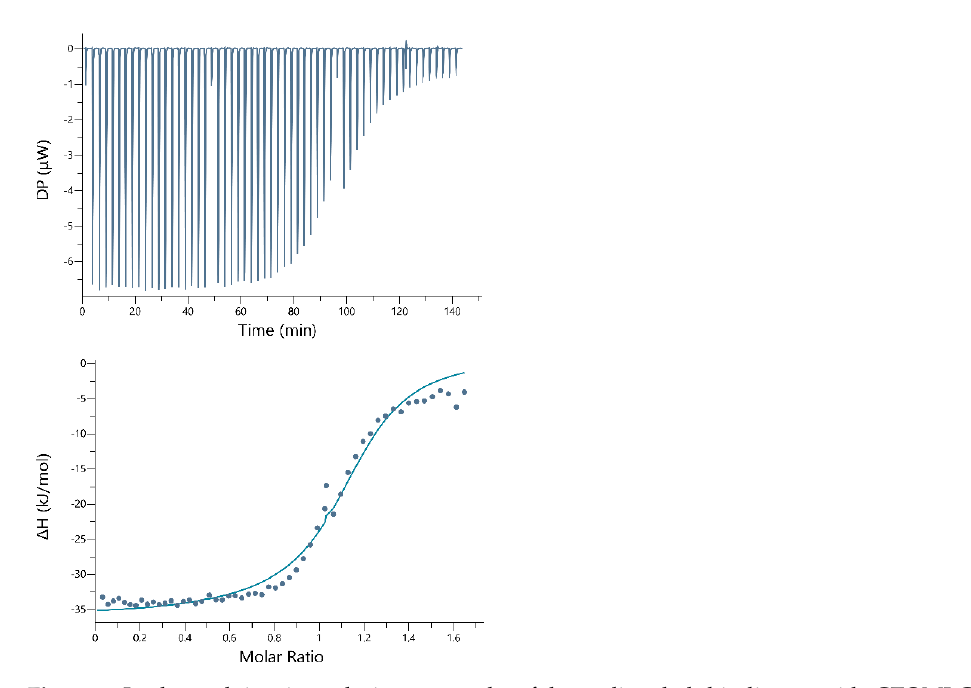
Figure 3. Isothermal titration calorimetry results of the cyclic cobalt-binding peptide CTQMLGQLCGGG with Co 2+ ions in Tris-HCl + NaCl, pH 7.4. Top: raw heat rate (µW) vs. time (min). Bottom: changes in enthalpy (kJ/mol) vs. molar ratio of the reactants. The data were fitted using a one-set-of-sites model.